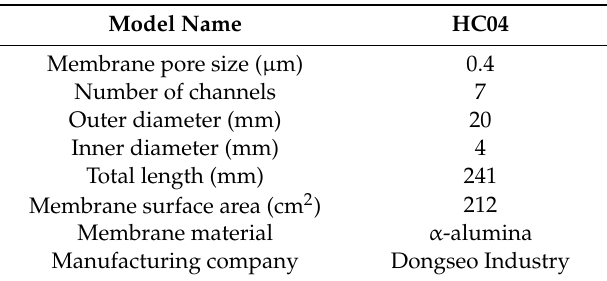
Table 1. Specification of the multichannel alumina microfiltration (MF) membrane utilized